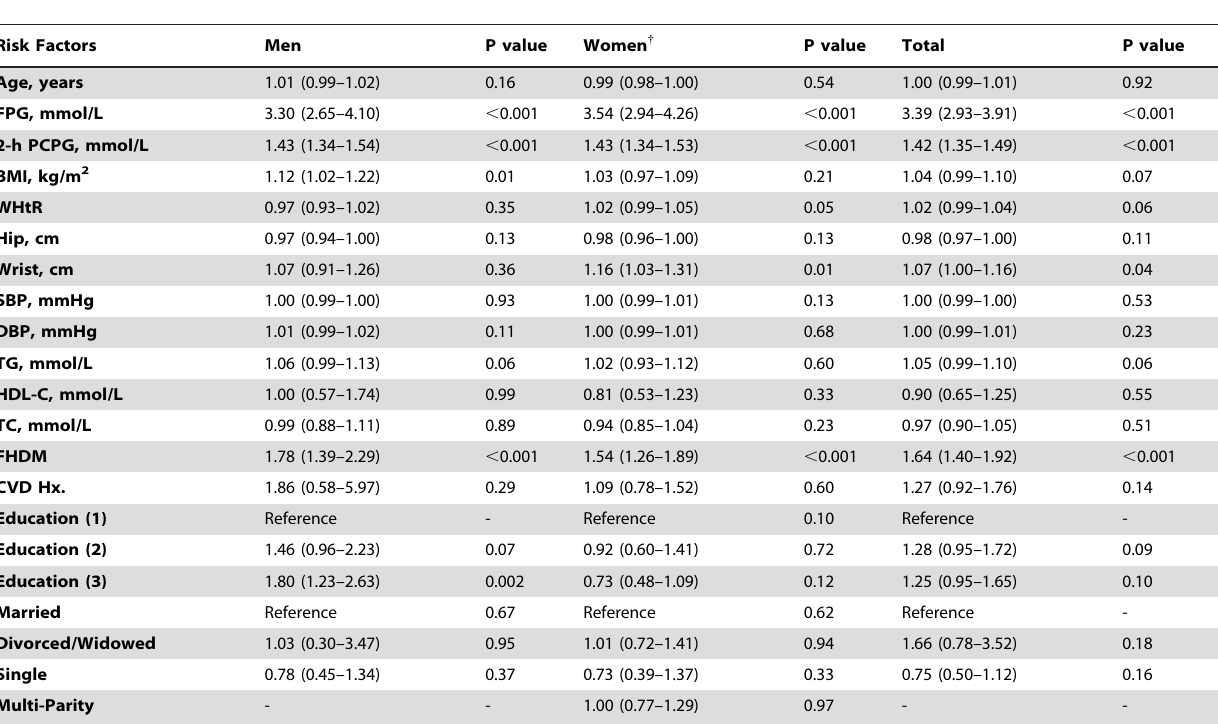
Table 4. Hazard Ratios and 95% Confidence Intervals (CI) from the Multi-variable Analysis of Potential Risk Factors in Relation to Diabetes Incidence by